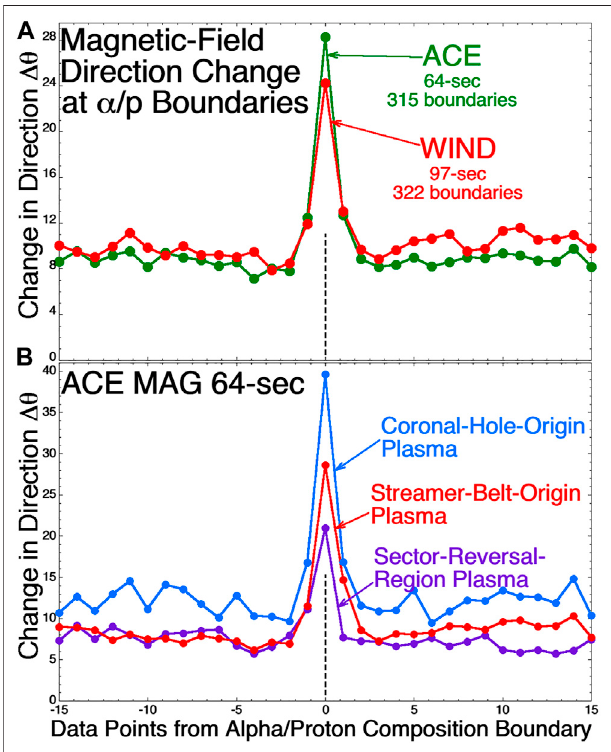
FIGURE 10 | Panel (A) plots the superposed epoch average of the temporal change in the magnetic- fi eld direction for 315 α /p boundary crossings by ACE (green curve) and for 322 α /p boundary crossings by WIND (red curve). In panel (B) the 315 ACE crossings are separated into the type of solar-wind plasma that each boundary was